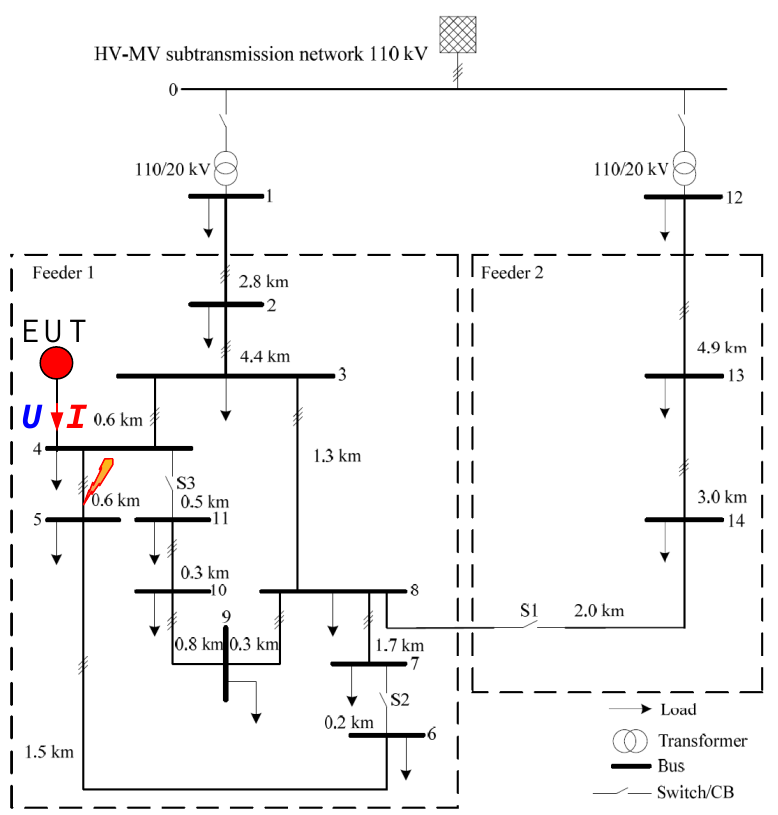
Figure 17. Single line diagram of CIGRE European MV distribution network benchmark [40].